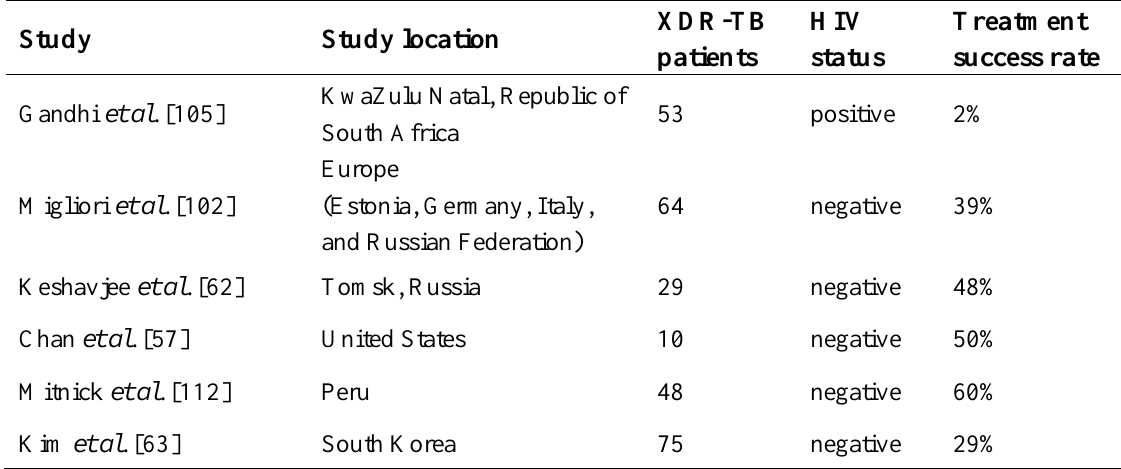
Table 4. XDR-TB treatment